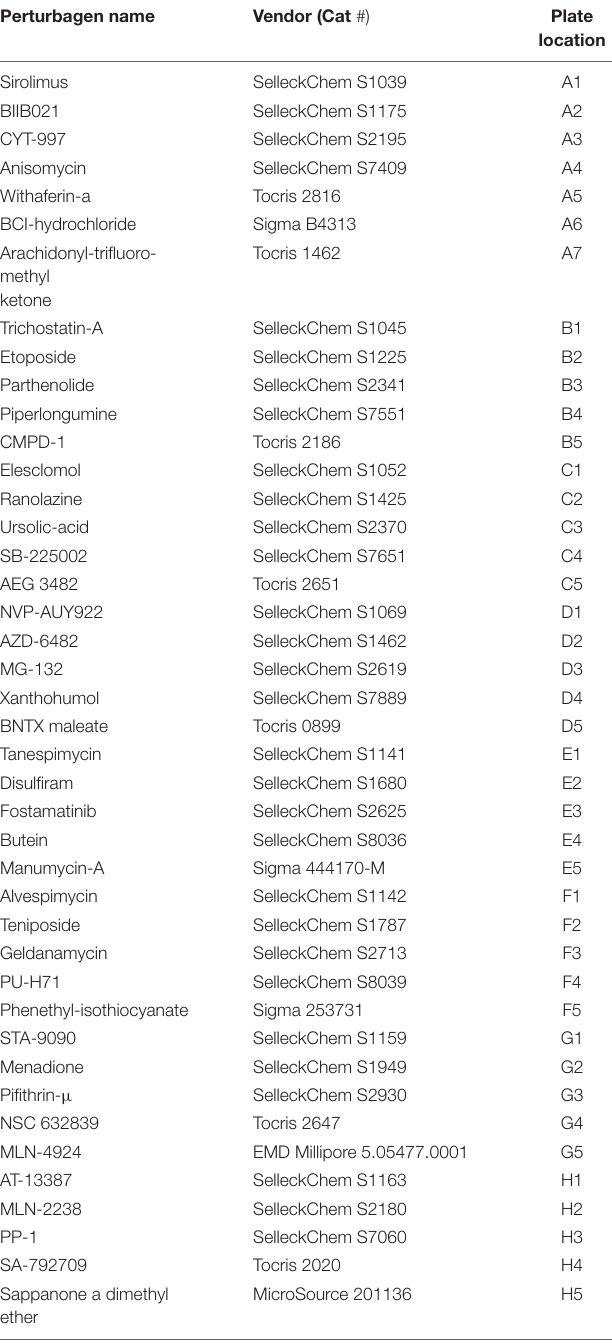
Table contains the name of each perturbagen compound, the vendor and catalog number of the compound purchased for the screen, and its location on the screening plate used as the stock concentration plate, which was used to determine perturbagen identity after screening.